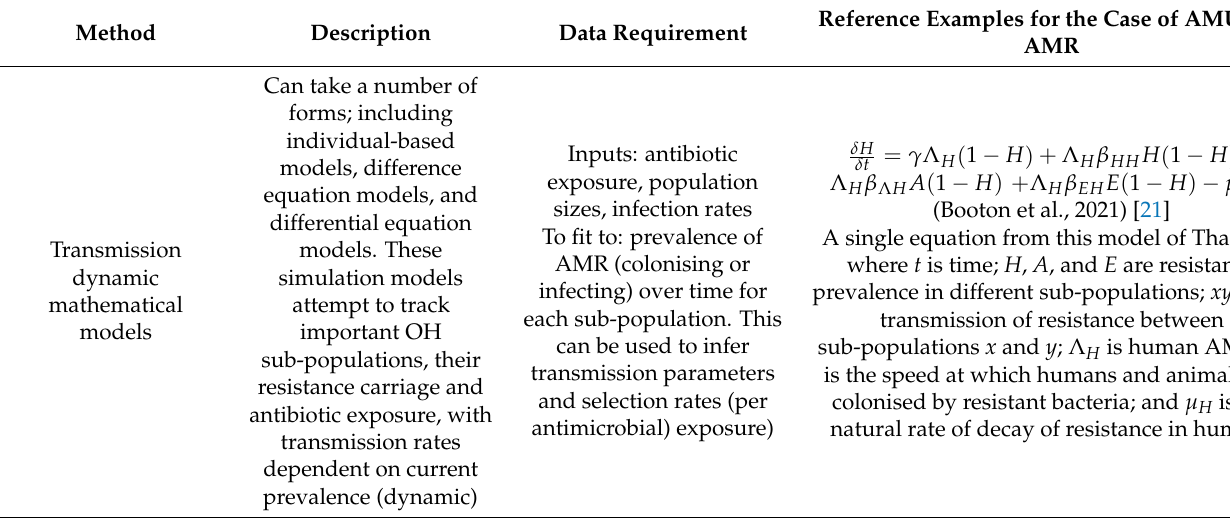
Table A2. Explanation of different methods for estimating the relationship between animal AMU and human AMR at the population